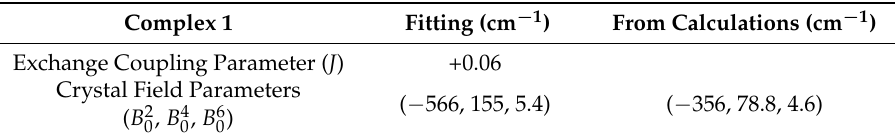
Table 1. Exchange coupling and crystal field parameters of complex 1 .